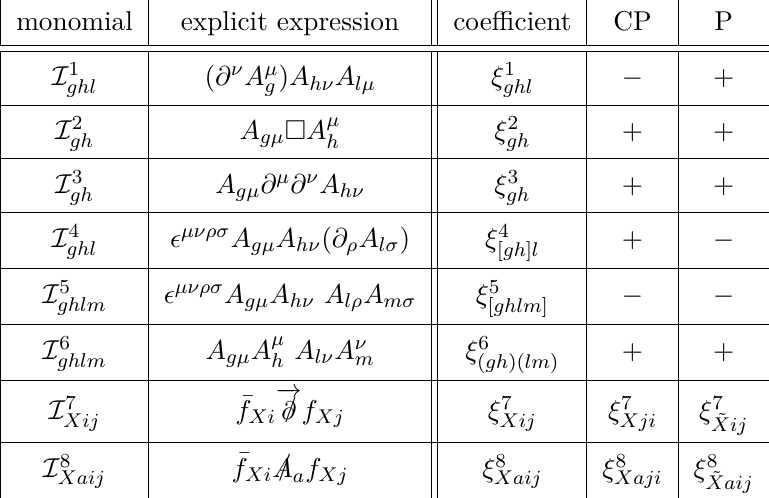
Table 2 . Basis of local, dimension-four operators, depending on gauge bosons, fermions and their derivatives relevant to build the counterterm S ct . Lorentz indices µ , ν , . . . run from 0 to 3. Also shown are the corresponding coefficients and their transformation properties under CP and P.